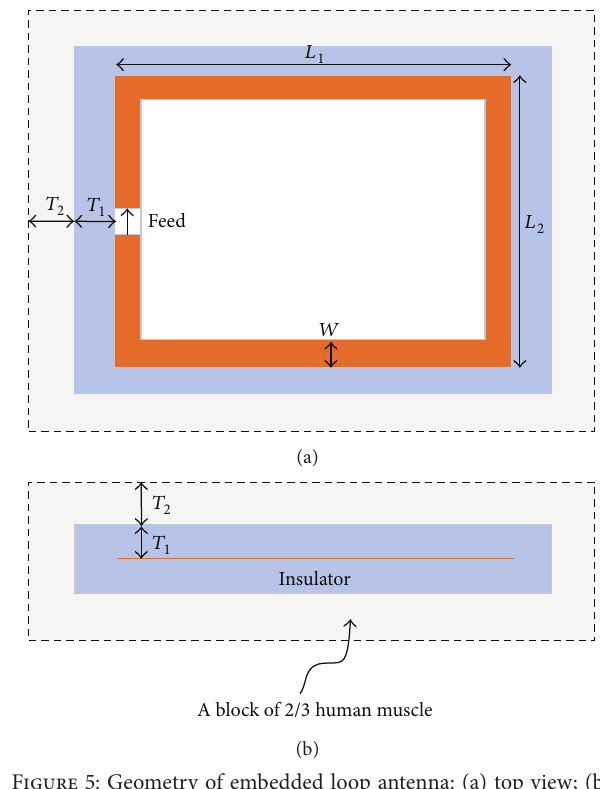
Figure 3: Normalized radiated power versus dielectric constant with large 𝑅 1 at 403 MHz.